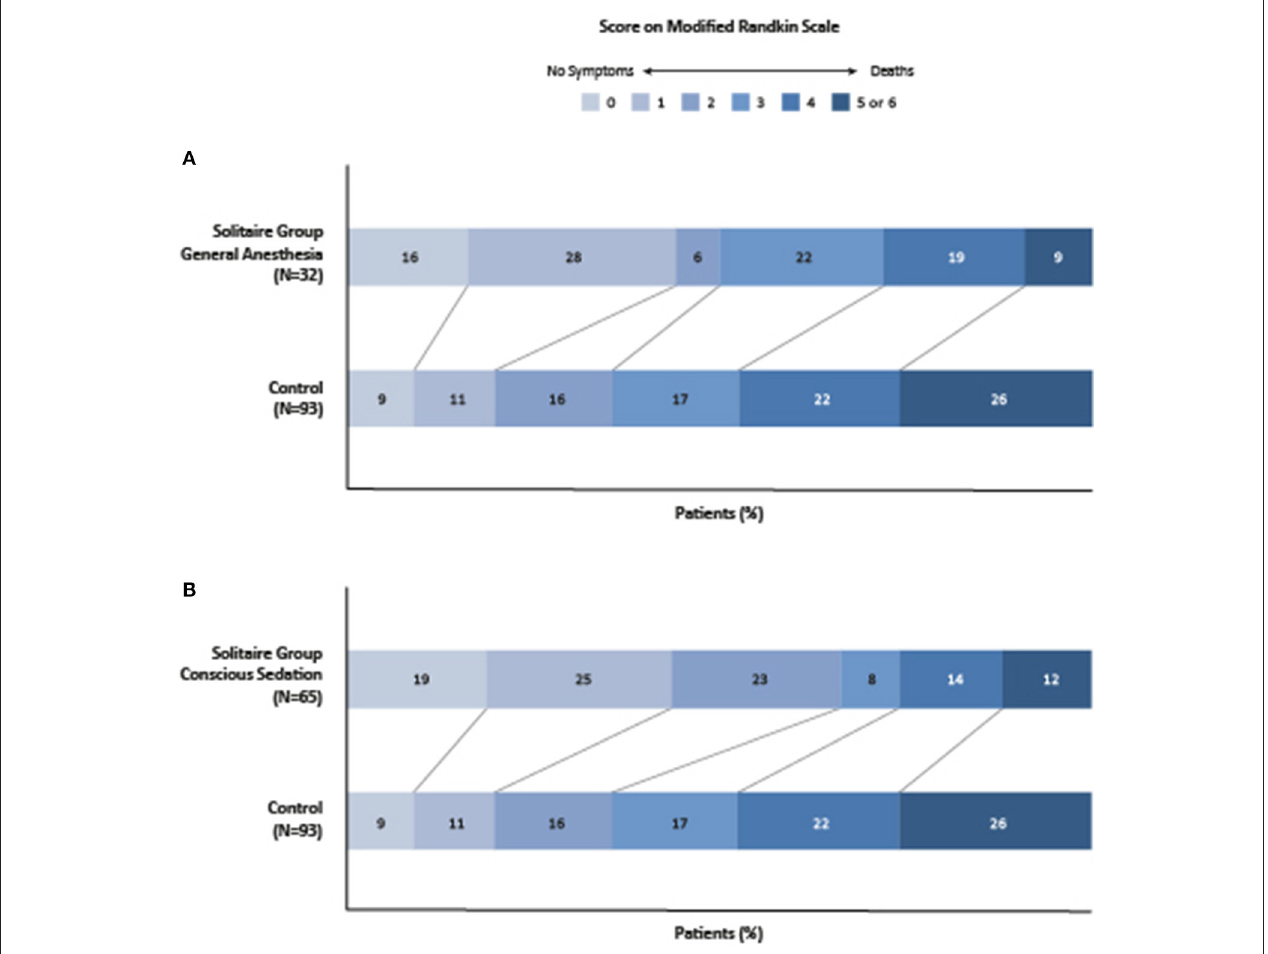
FIGURE 1 | Functional outcomes at 90 days, according to the score on the modified ranking scale. The figure shows the subgroup analyses of mRS shifts comparison between GA-policy patients versus control group (A) and CS-policy patients versus control group (B) in SWIFT PRIME trial. Shown are the 90 day scores on the modified ranking scale for the patients in the two treatment groups. Score range from 2 to 6, with 0 indicating no symptoms, 1 no clinically significant disability (able to carry out all usual activities, despite some symptoms), 2 slight disability (able to look after own affairs without assistance but unable to carry out all previous activities), 3 moderate disability (requires some help but able to walk unassisted), 4 moderately several disability (unable to attend to bodily needs without assistance and unable to walk unassisted), 5 severe disability (requires constant nursing care and attention, bedridden, and incontinent), and 6